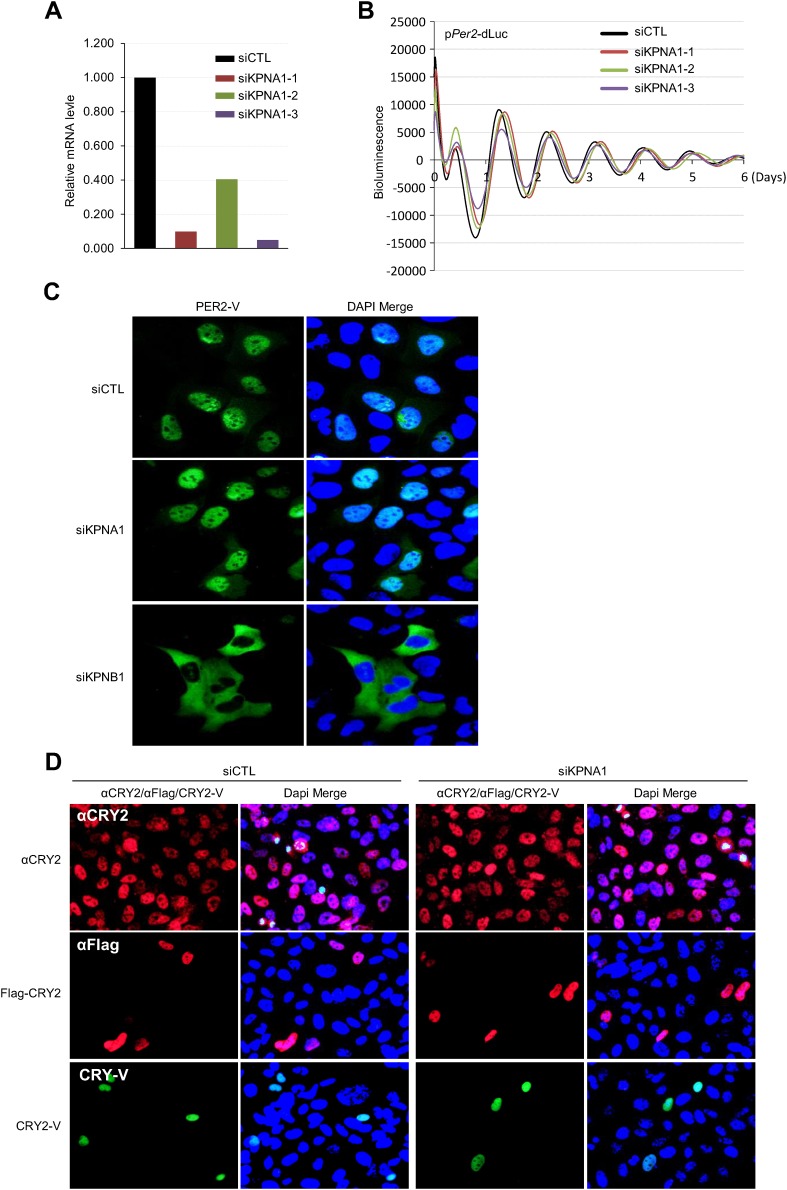
Inhibition of KPNA1 (importin α5) does not significantly affect PER2 and CRY2 nuclear localization and cellular clock rhythmicity.(A) Quantitative RT-PCR analysis of knockdown efficiencies of three siRNAs targeting KPNA1 (siKPNA1-1; gray red, siKPNA1-2; light green, siKPNA1-3; violet), introduced in U2 OS cells as indicated. (B) KPNA1 depletion does not affect circadian promotor activity rhythm. 48 hr after treatment with control siRNA (siCTL) or each of three KPNA1 siRNAs (siKPNA1-1, siKPNA1-2, siKPNA1-3) in pPer2-dLuc reporter cells, the cells were synchronized with Dex and monitored in real-time bioluminescence recorder. (C) KPNA1 depletion does not affect subcellular localization of PER2. Fluorescence microscopic analysis of the effect of KPNA1 or KPNB1 depletion on subcellular localization of PER2. Representative fluorescence images of U2 OS cells stably expressing PER2-Venus (PER2-V) in the presence of control (siCTL: upper panels), KPNA1 (siKPNA2: middle panels), or KPNB1 siRNA (siKPBN1: lower panels) were captured by fluorescence imaging microscopy using specific filter sets for FITC (green; PER2-V) and and DAPI (Blue; Nuclei). (D) Fluorescence microscopic analysis of the effect of KPNA1 depletion on subcellular localization of CRY2. Representative fluorescence images of subcellular localization of endogenous CRY2 (upper panels), or ectopically expressed Flag-CRY2 (middle panels), CRY2-Venus (CRY2-V; lower panels) in U2 OS cells treated with control siRNA (siCTL; left panels) or KPNA1 siRNA (siKPNA1; right panels). The images were taken using specific filter sets for TRITC (Red; αCRY2, Flag-CRY2), FITC (green; PER2-V), and DAPI (Blue; Nuclei). DAPI (Blue) merged images was presented in each of the image panels.